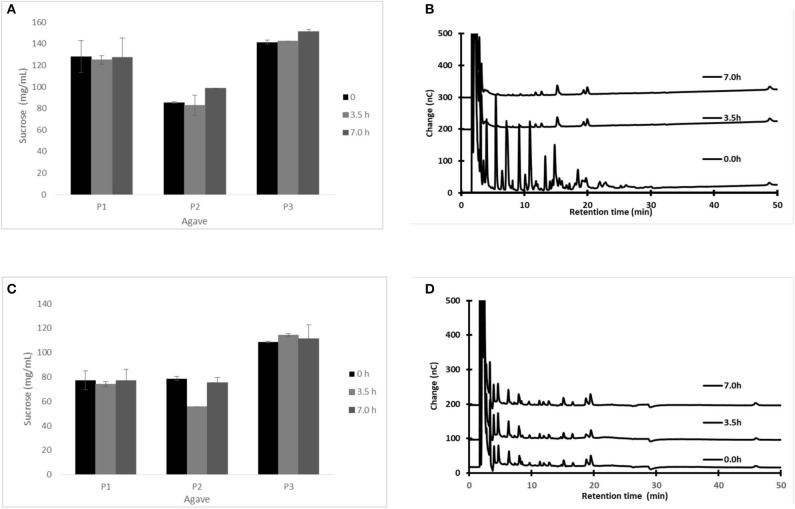
Sugar content in aguamiel at different collection times (0, 3.5, and 7 h after scraping) during a single day collection: sucrose (A,C) and fructo-oligosaccharide profile (B,D). Scraping as usual before collection (A,B) or scraping before each aguamiel sample was collected (C,D). Sucrose was measured by HPLC; FOS was measured by HPAEC-PAD. The HPAEC-PAD chromatograms (B,D) for plant P2 are shown as an example. Statistical differences: p-value for sucrose concentration in the traditional process for the three plants (P1, p = 0.968; P2, p = 0.111; and P3, p = 0.012). When the plant was scraped before sampling (P1, p = 0.779; P2, p = 0.005; and P3, p = 0.73). The cajete was previously emptied before sampling to avoid dilution.